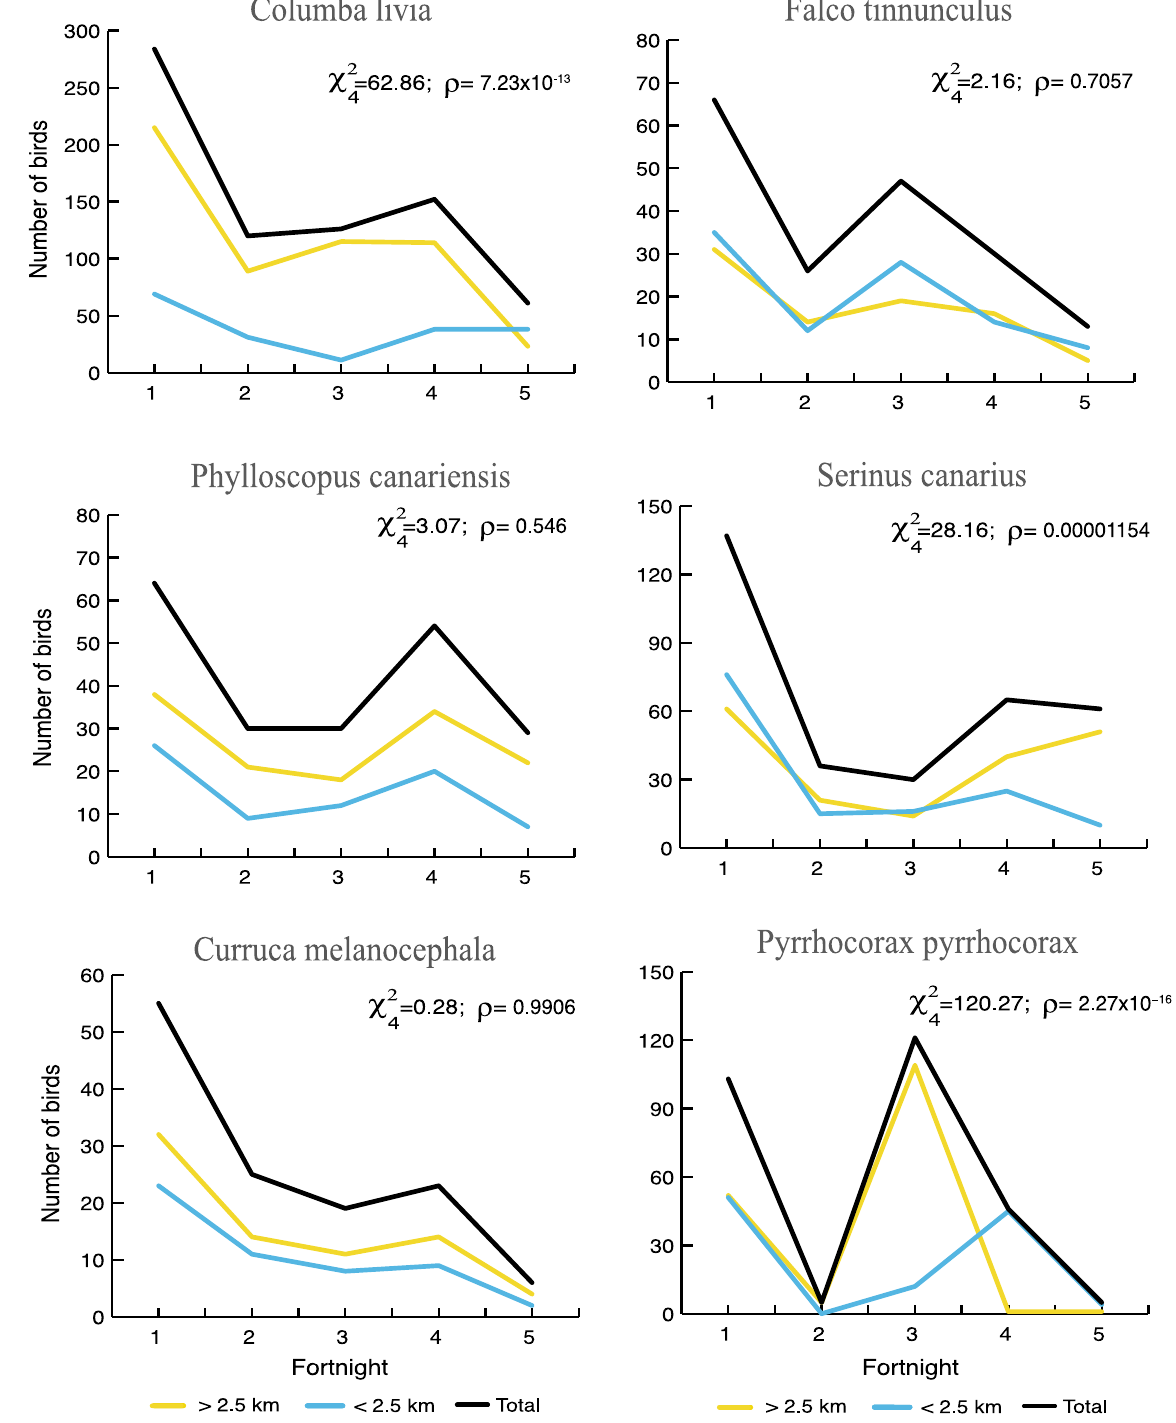
Figure 4. Time sequence of the most common bird species sightings or songs/calls during the Tajogaite eruption and their distances from the crater (within or beyond 2.5